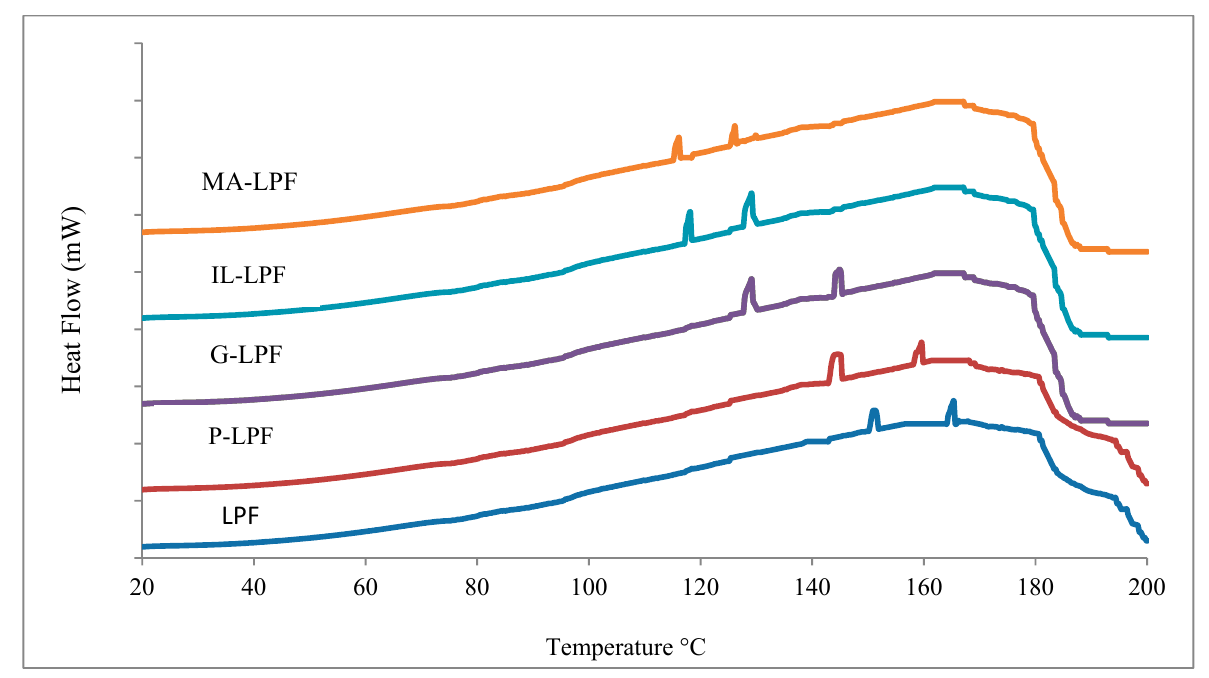
Figure 3. DSC analysis of synthesized LPF resin. Table 2. The properties of the panels made from synthesized resins.